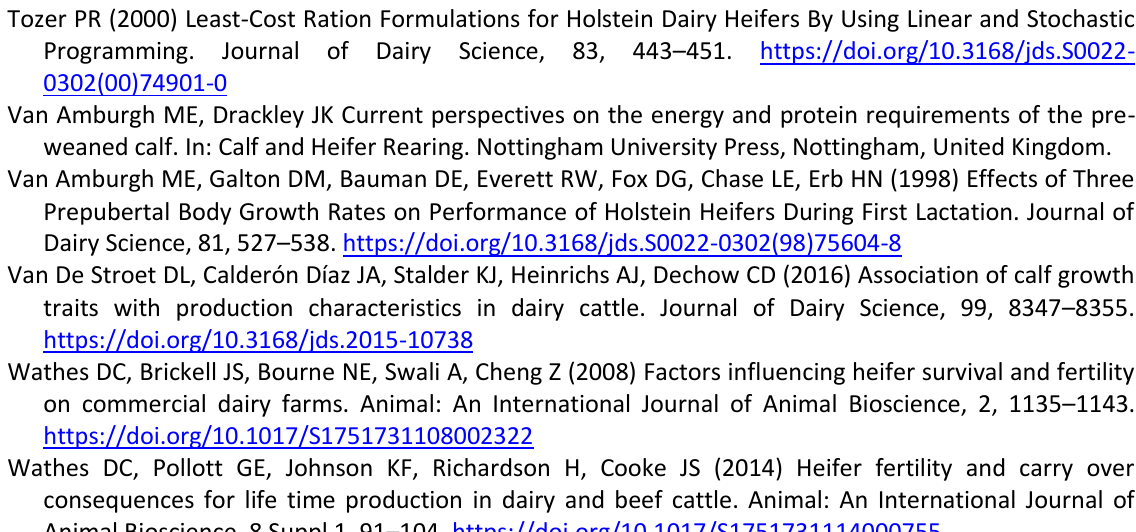
Appendix Fig.1 can be found together with the preprint on biorxiv: